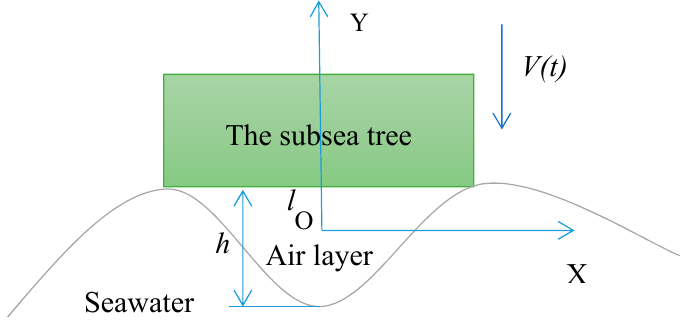
Figure 2. Theoretical model of the subsea tree into water.